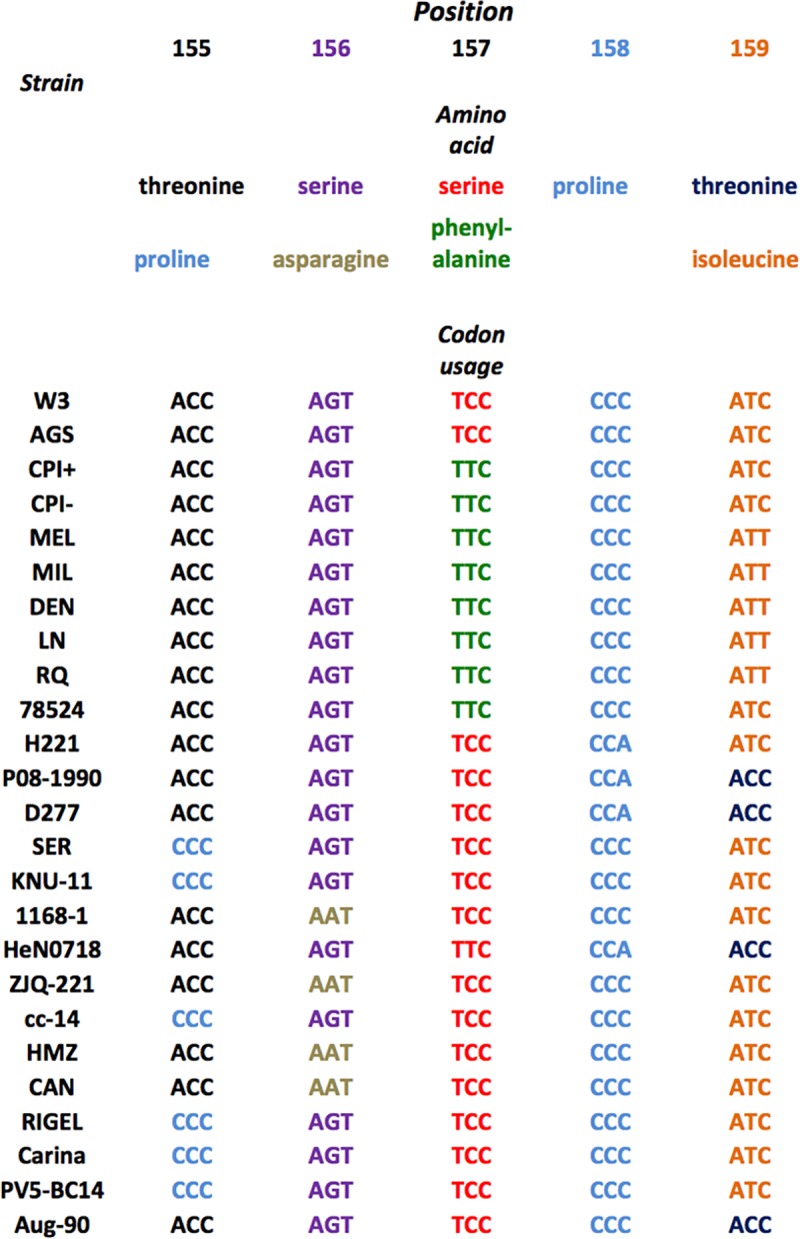
Amino acid and codon usage of strains of PIV5 in the NCBI database between amino acids 155–159 in P.Colours of the indicated amino acids are the same colours as for their respective codons.